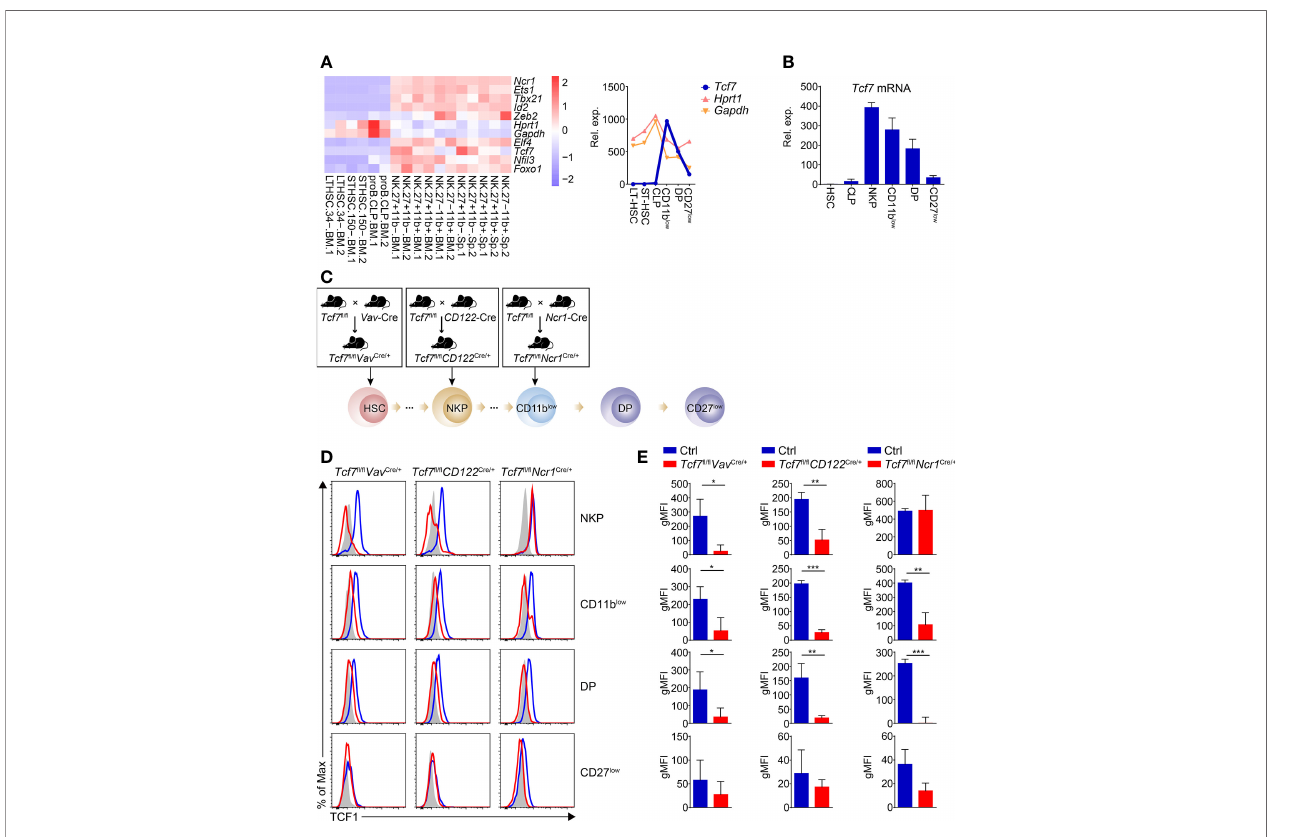
FIGURE 1 | Analyzing dynamic expression of Tcf7 in NK subsets and detecting Tcf1 deletion ef fi ciency in NK cells from the three conditional targeting mouse models. (A) Left: Heatmap showing the mRNA abundance of Tcf7 compared with several NK signature genes in various cell subsets by published RNA-seq data (GSE109125); Right: A line chart showing normalized counts of Tcf7 expression trend in continuous developmental stages of NK cells in comparison with housekeeping genes Gapdh and Hprt1 . (B) Analysis of the relative Tcf7 abundance by qPCR in HSC, CLP, NKP, CD11b low (CD3e − NK1.1 + CD11b − CD27 + ), DP (CD3e − NK1.1 + CD11b + CD27 + ), and CD27 low (CD3e − NK1.1 + CD11b + CD27 - ) cells. Gapdh was arbitrarily set to 1,000 and the relative abundance of Tcf7 in each subset was normalized, accordingly (n ≥ 3 for each group). (C) Schematic graphs showing the strategies for generating mouse models. Tcf7 fl / fl mice were mated with Vav -Cre, CD122 -Cre or Ncr1 -Cre transgenic mice, respectively. The Cre recombinase initially expressed in each developmental stage was indicated with a black arrow. (D) The expression of Tcf1 in the indicated NK subsets was analyzed with fl ow cytometry. Representative histogram plots showed the expression of Tcf1 with shadow (Isotype control), blue line (littermate controls), and red line (conditional knock out mice as indicated), respectively. (E) Cumulative data of geometric mean fl uorescence intensity (gMFI) from panel (D) are shown, accordingly (n = 3 for each group). The gMFIs were calculated by deducting the value of Isotype controls from those of either Ctrl or knockout mice. Statistical signi fi cance was determined by one-tailed Student ’ s t-test. *P < 0.05, **P < 0.01, and ***P < 0.001. Data are means ±